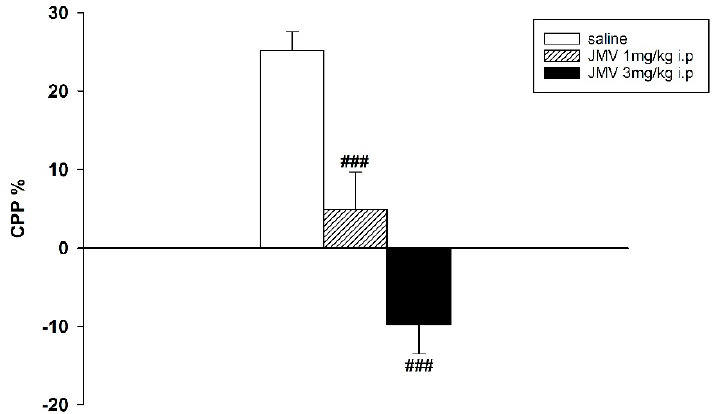
Figure 1. Effects of GHS-R1A antagonist on 2 mg/kg methamphetamine-induced conditioned place preference (CPP) in rats. After eight days of conditioning with 2 mg/kg i.p. methamphetamine, JMV2959 was administered in a single dose 20 min before testing ( N = 8; means ± SEM). The effects of JMV2959 pretreatments in comparison to the saline group are expressed as ### p < 0.001.